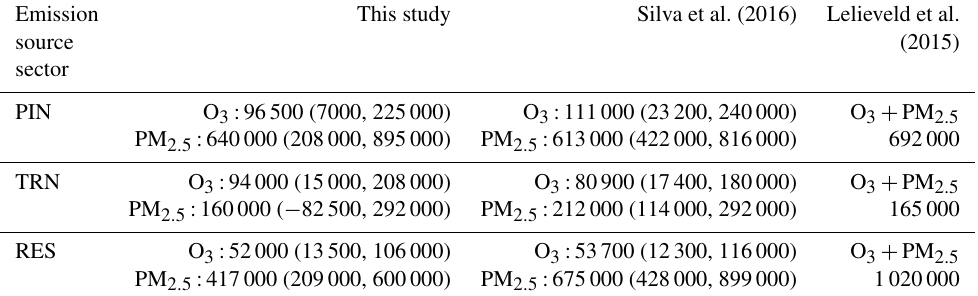
Table 7. Comparison of O 3 - and PM 2 . 5 -related premature deaths attributable to PIN, TRN, and RES emissions with previous studies. Results from this study (for 20% reductions) are multiplied by 5. For Silva et al. (2016), we combine results for “energy” and “industry” to represent PIN, and use “land transportation” to represent TRN and “residential & commercial” to represent RES. For Lelieveld et al. (2015), we combine the “power generation” and “industry” sectors to represent PIN, and use “land traffic” to represent TRN and “residential energy” to represent